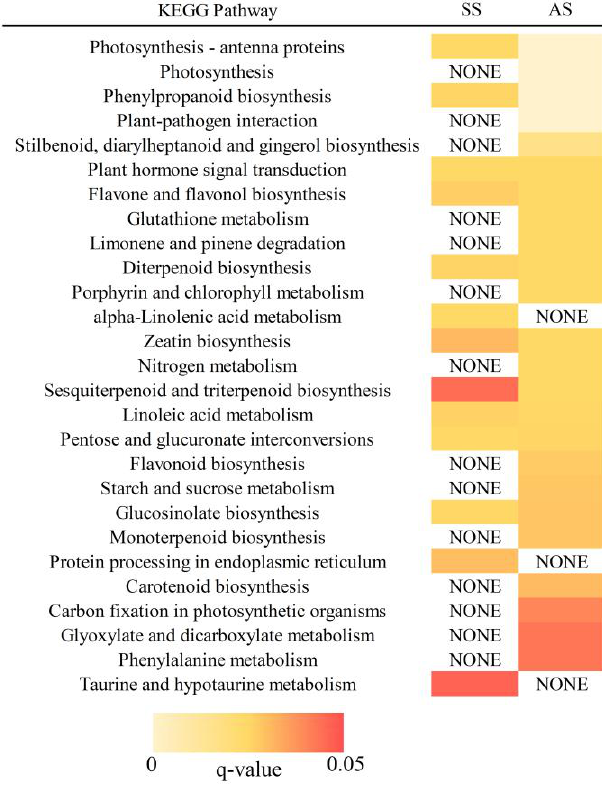
Figure 3. Heatmap of Kyoto Encyclopedia of Genes and Genomes (KEGG) pathway analysis of DEGs in the SS and AS treatments. A total of 13 and 24 enriched KEGG pathways were identified in the SS and AS samples, respectively. The box colour represents the q-value of the pathway.